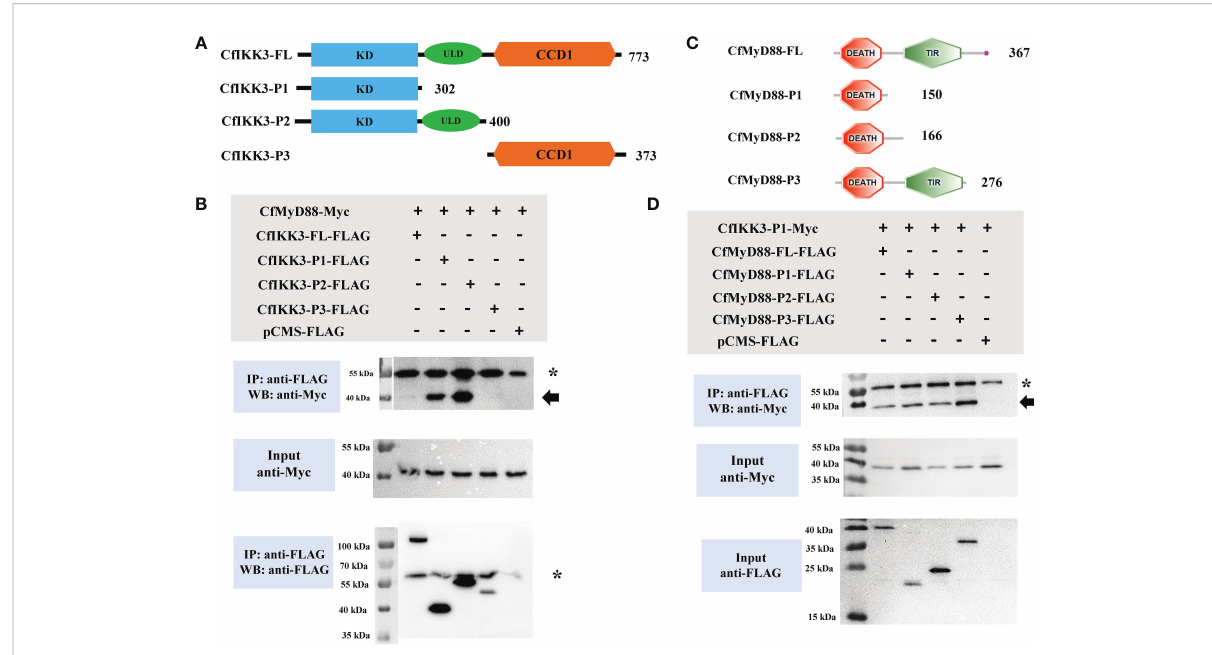
FIGURE 5 (A) Schematic representations of the wild-type full-length CfIKK3 protein (CfIKK3-FL) and truncated mutant CfIKK3-P1, CfIKK3-P2, and CfIKK3- P3 proteins. The protein lengths and domains are annotated. (B) Interaction between CfIKK3 and CfMyD88, as veri fi ed using co- immunoprecipitation (co-IP) assays. The co-IP of CfMyD88 proteins with various CfIKK3-FLAG proteins (CfIKK3-FL, CfIKK3-P1, CfIKK3-P2, and CfIKK3-P3) was facilitated using anti-FLAG M2 magnetic beads and analyzed by western blot assay using the anti-Myc antibody (top). Input samples were detected using anti-Myc (middle) and anti-FLAG antibodies (bottom), respectively, to con fi rm the Myc- and FLAG-fused protein expression. CfMyD88-Myc could be detected in the anti-FLAG immunoprecipitates of co-transfected (CfIKK3-FL, CfIKK3-P1, and CfIKK3-P2) cell extracts, indicating the interaction of CfMyD88-Myc with CfIKK3-FL-FLAG (weak interaction), CfIKK3-P1-FLAG, and CfIKK3-P2-FLAG. The asterisk represents the heavy chain of mouse IgG. (C) Schematic representations of the wild-type full-length CfMyD88 protein (CfMyD88-FL) and truncated mutant CfMyD88-P1, CfMyD88-P2, and CfMyD88-P3 proteins. The protein lengths and domains are annotated. (D) Interaction between CfIKK3-P1 and CfMyD88, as veri fi ed using co-immunoprecipitation (co-IP) assays. Co-IP results indicated the interaction of CfIKK3-P1- Myc with CfMyD88-FL-FLAG, CfMyD88-P1-FLAG, CfMyD88-P2-FLAG and CfMyD88-P3-FLAG. The asterisk represents the heavy chain of mouse